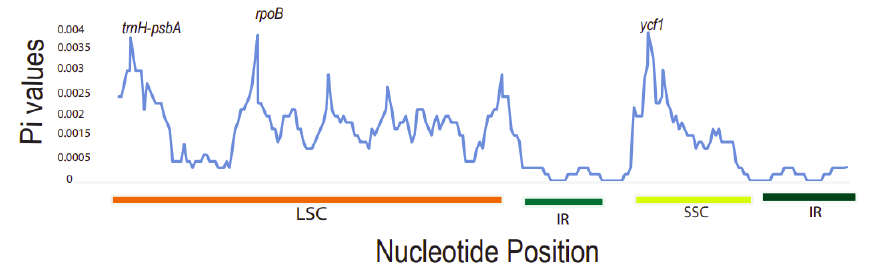
Figure 7. A sliding window analysis of nucleotide variability (Pi) values of different regions of Toddalia . X -axis: position of the midpoint of a window, Y -axis: nucleotide diversity of each window.